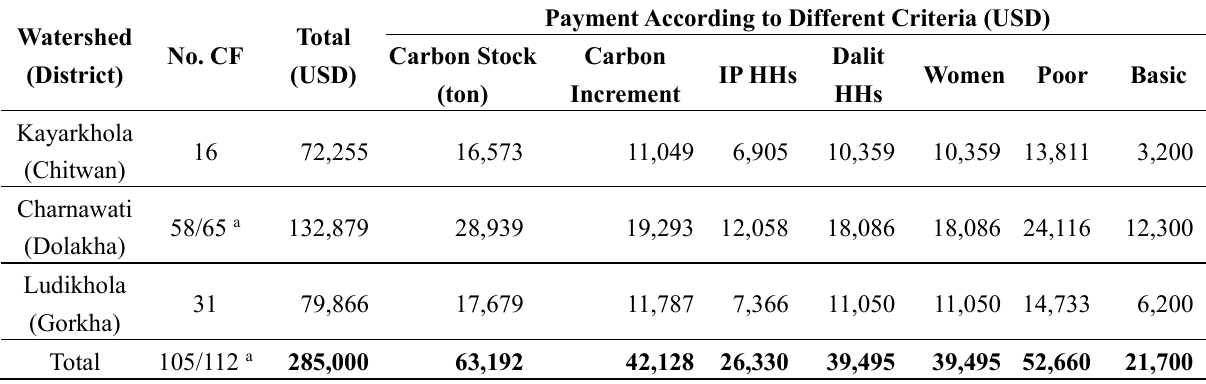
Table 4. Total payments in three years and breakdown according to different